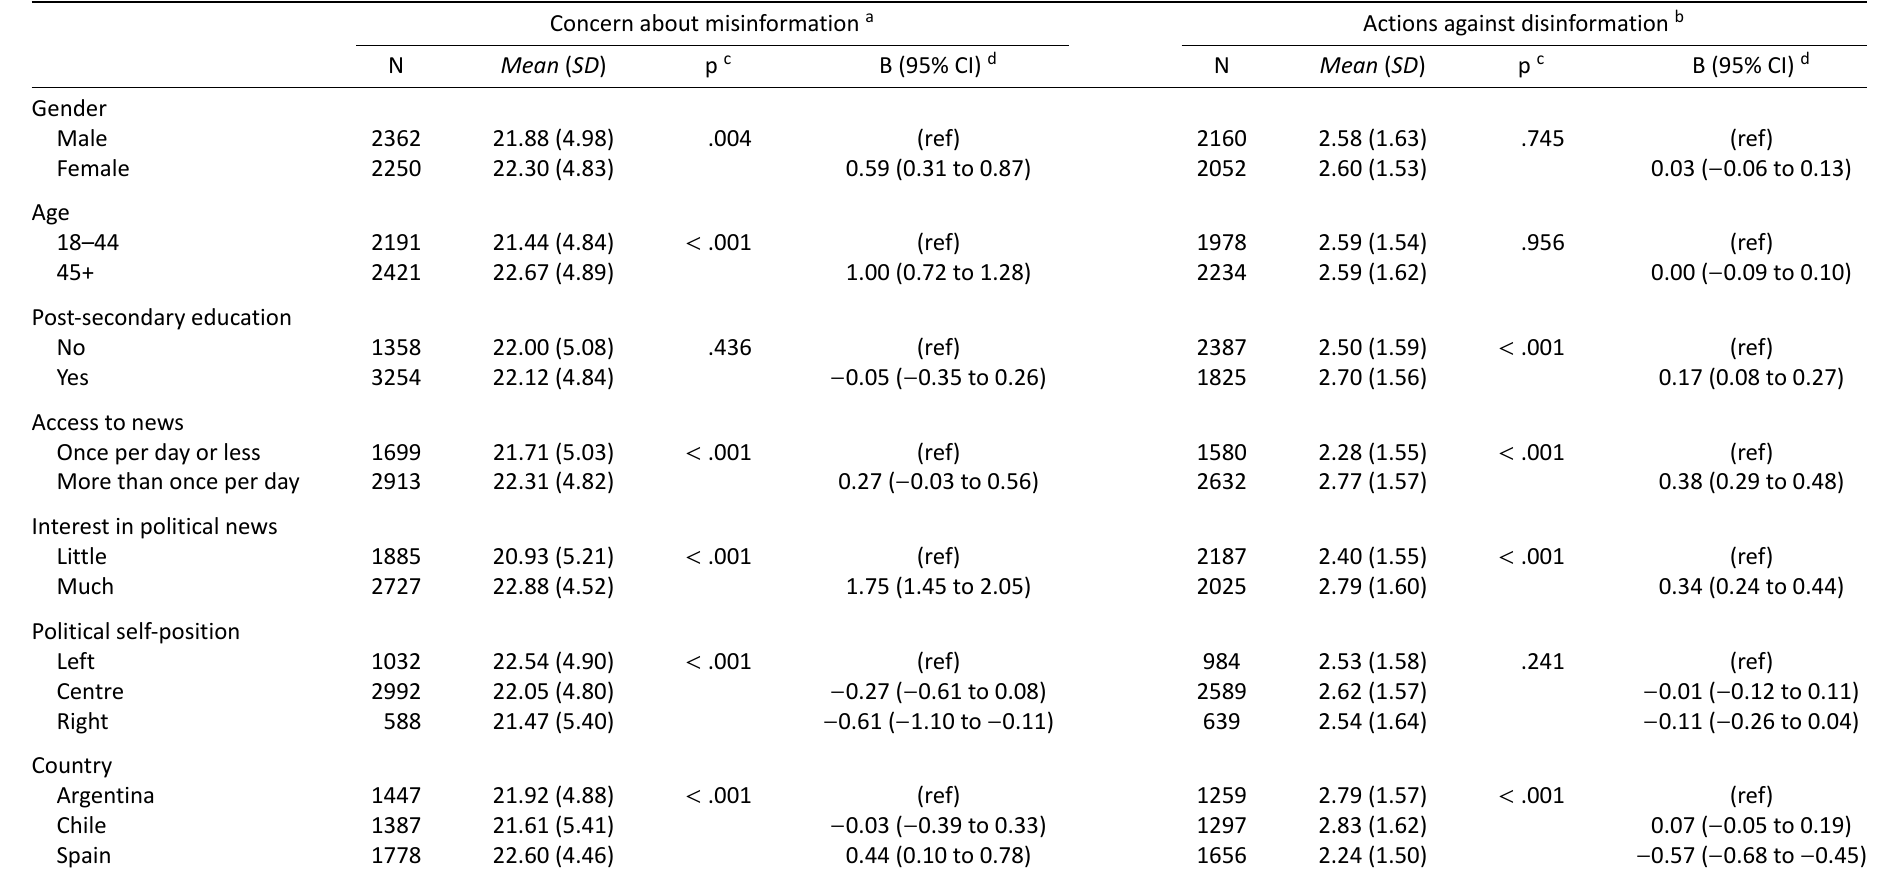
Table 8. Predictors associated with concern about misinformation and with actions against